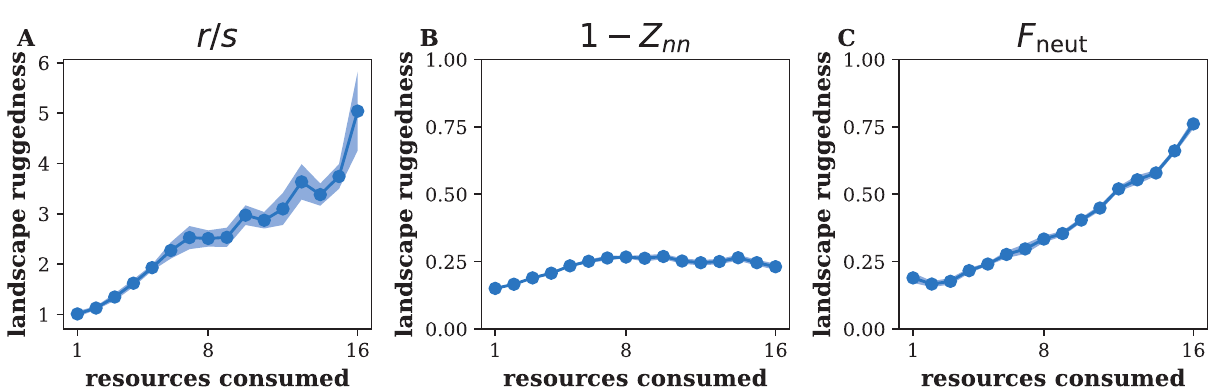
Fig 5. Ruggedness of community function landscapes. All metrics of ruggedness increased with niche overlap. Different panels correspond to different metrics of ruggedness. The plots report the average and the standard error of the mean obtained from ten independently generated species pools. The complexity of the landscape was controlled by varying the average number of resources that each species consumed, M consumed , while keeping the total number of resources, M total , fixed at M total = S = 16. See Methods for the complete description of these simulations. The community function here was community diversity; see S3 Fig for other community